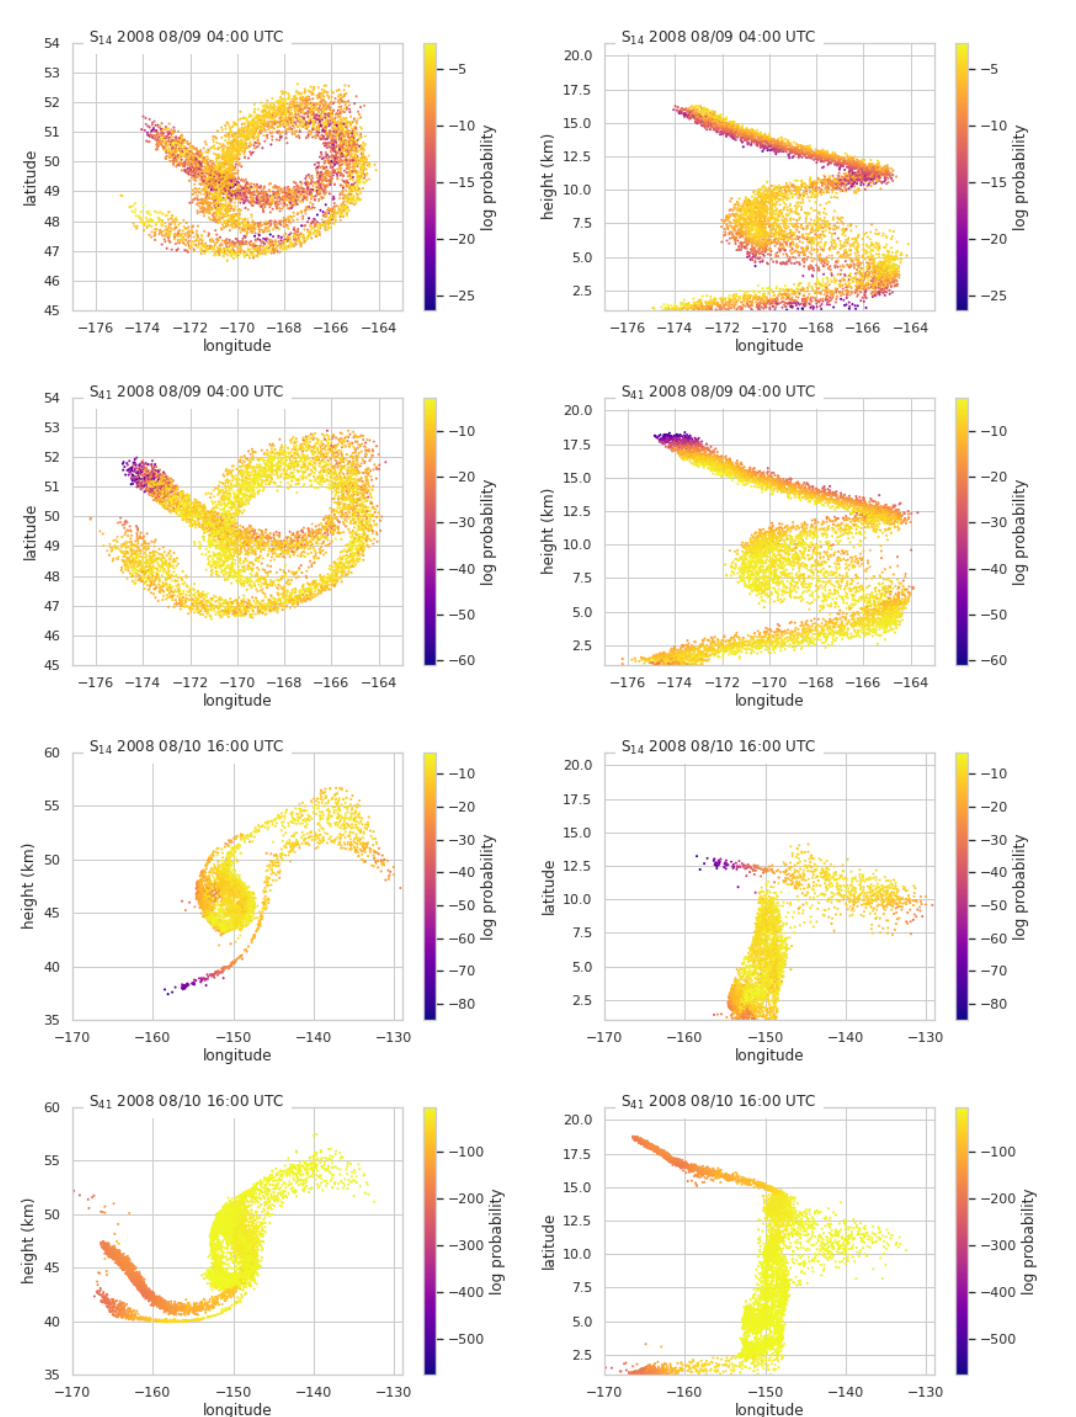
Figure 8. log probability of each particle position. The left column shows a projection onto the latitude, longitude plane and the right column shows a projection onto the height, longitude plane. The date is noted at the top of each figure. S ij indicates that the probabilities were calculated using the particle positions j and the fit to particle positions i . For example, S 41 shows positions of the smallest particle size with how probable it is that they could belong to a fit to the largest particle size. Note the differing color scales. Low values indicate poor fit and regions where the overlap between the location of the two particle sizes is